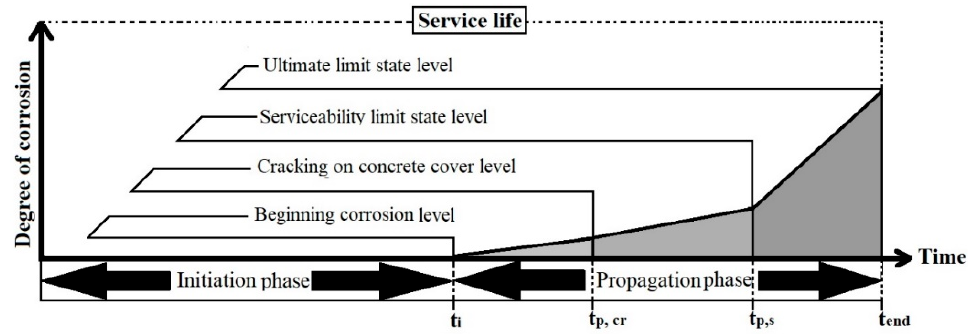
Figure 3. The service life of rebars in an RC structure according to the model by Tuutti [54]. According to the following Equation, the total time of chloride corrosion ( t l ) is the service life of the bridge structure’s reinforcements, obtained by summing the initiation and propagation phases together [56].